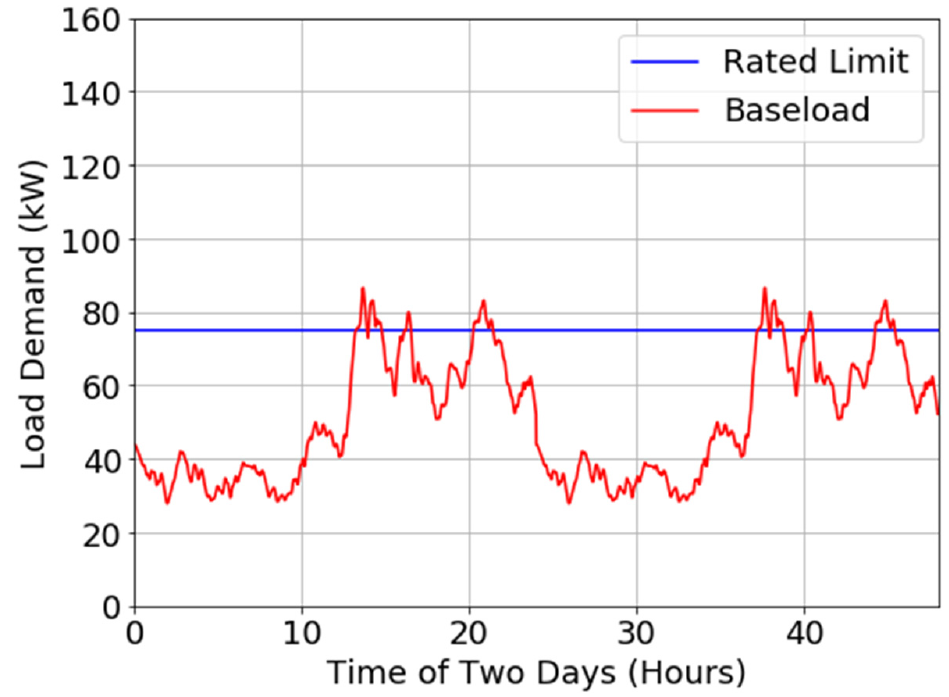
Figure 3. Transformer baseload on 25 September 2014. Table 1. User workplace scheduling